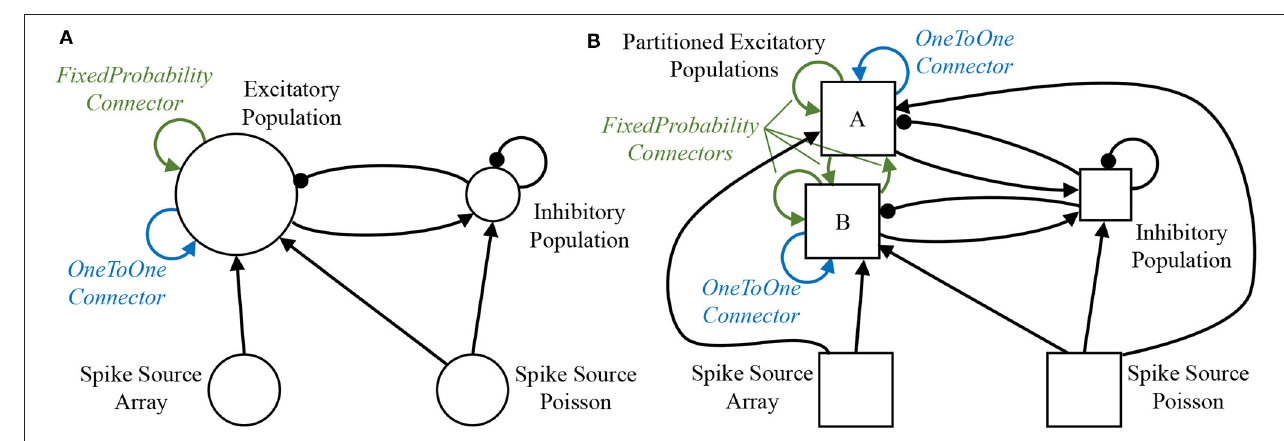
FIGURE 3 | Network partitioning to fit machine resources. (A) Application graph generated from interpretation of PyNN script: circles represent PyNN populations, and arrows PyNN projections. (B) Machine graph partitioned into vertices and edges to suit machine resources: squares represent populations (or partitioned sub-populations) of neurons which fit on a single SpiNNaker core—hence the model described by the machine graph in (B) requires 5 SpiNNaker cores for execution.